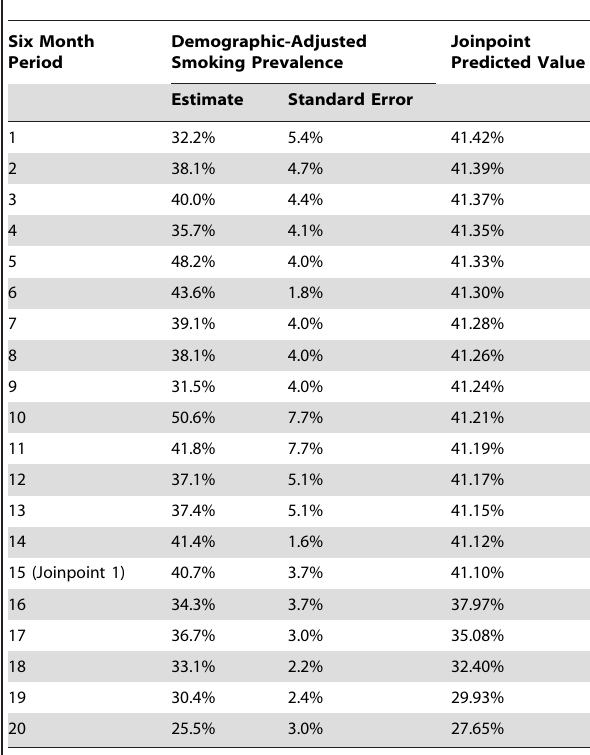
Table 3. Demographic-Adjusted Smoking Prevalence for Joinpoint Analysis, 1999–2008.